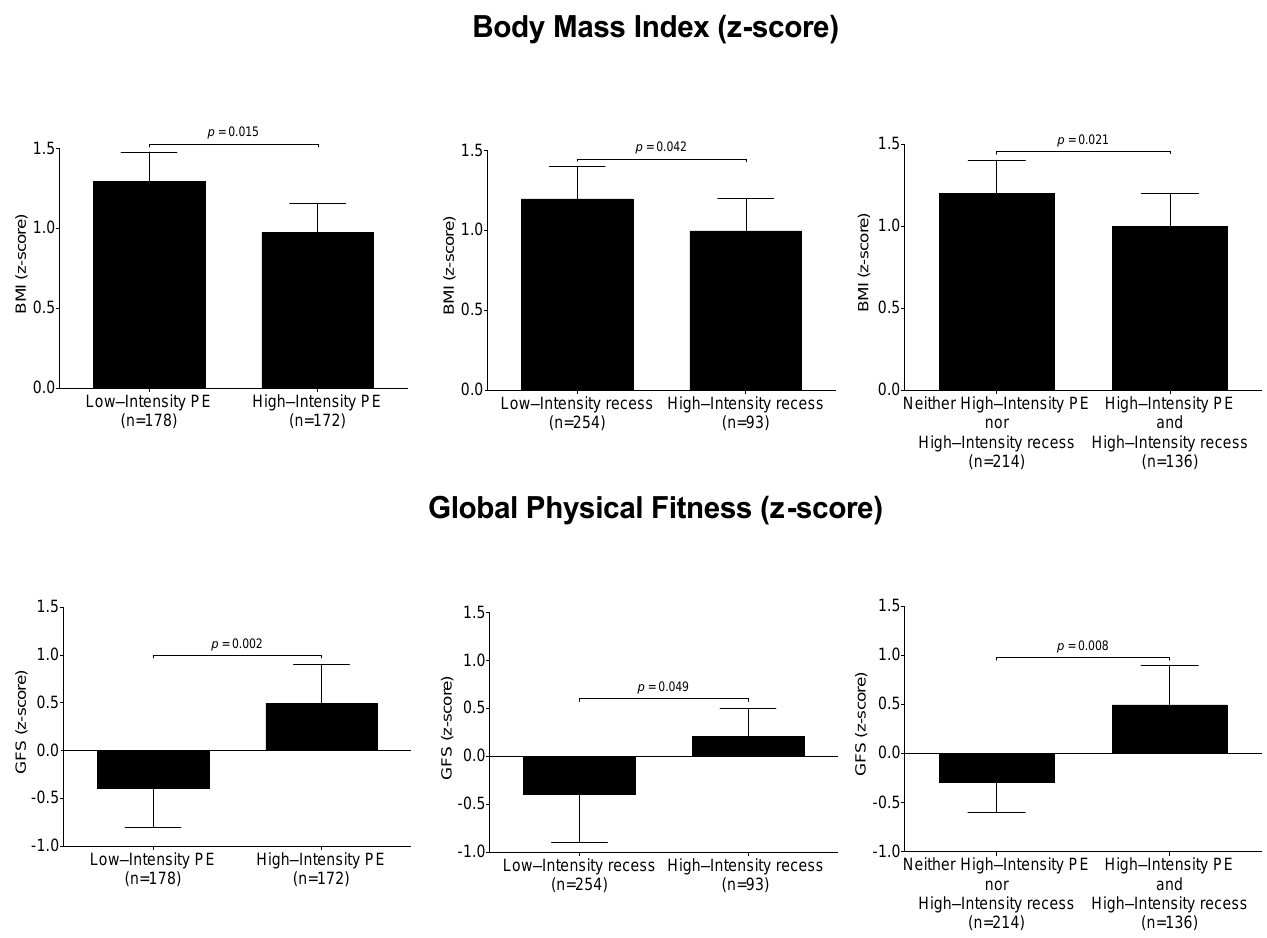
Figure 2. Mean differences in body mass index (z-score) and global physical fitness (z-score) in relation to physical activity intensity during Physical Education classes and school recesses. Analyses were adjusted by sex, age, type of schooling, area of residence, immigrant status, daily screen time, and weekly sport activities. BMI, body mass index; GFS, Global Fitness Score; PE, physical education.